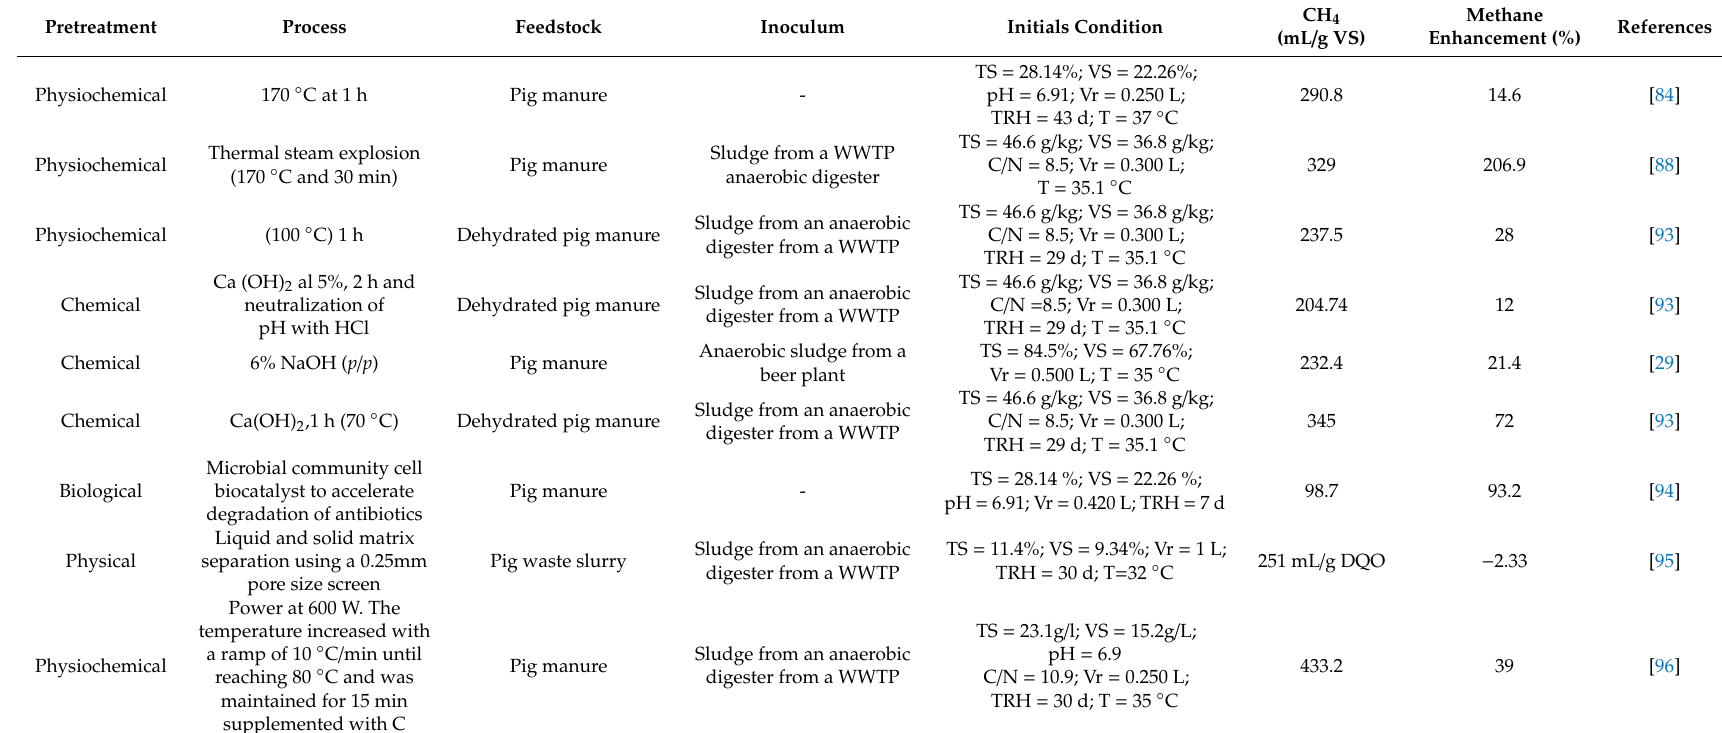
Table 4. E ff ects of the di ff erent pretreatments applied to pig